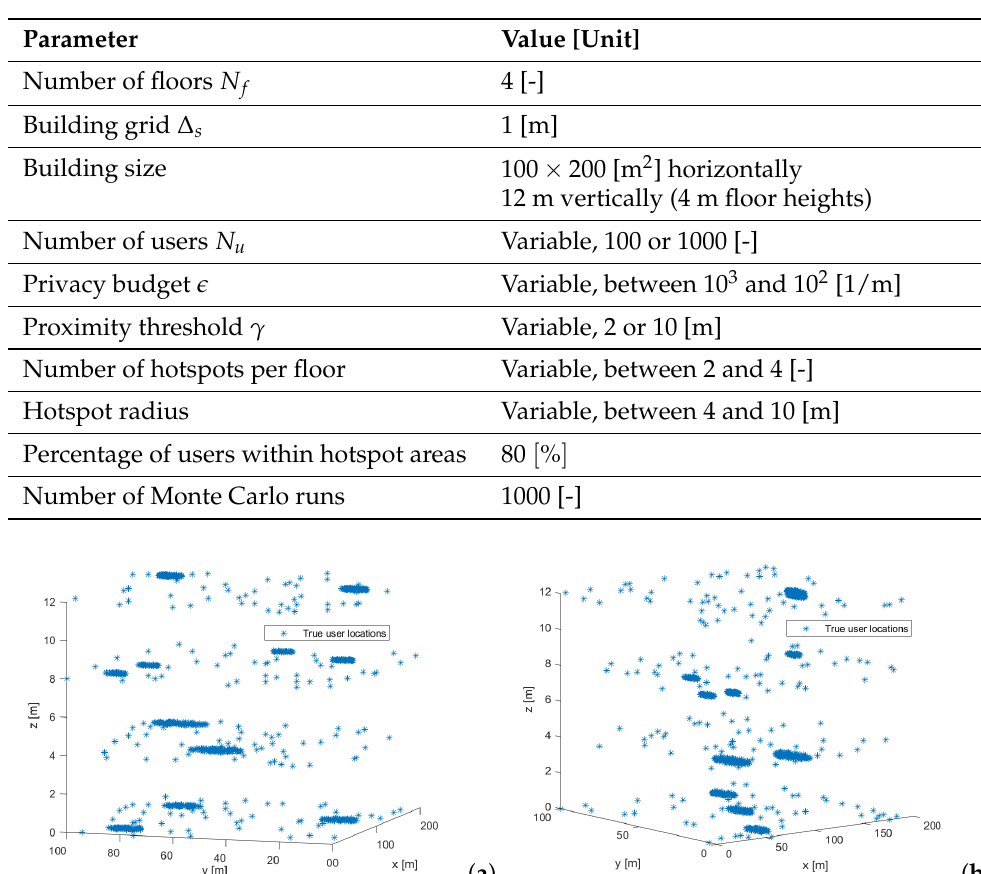
Table 2. Main simulation parameters (unless otherwise specified in plots’ titles).